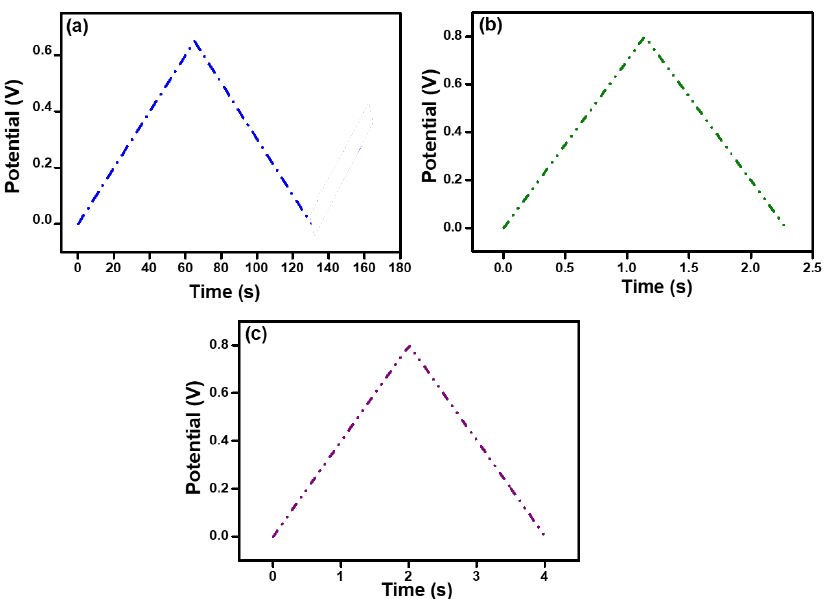
Figure 6. Galvanostatic charge – discharge (GCD) curves at 100 mA/g of ( a ) pure alginate hydrogel, ( b ) alginate hydrogel with 2.5 mL PEDOT:PSS, and ( c ) alginate hydrogel with 5 mL PEDOT:PSS.